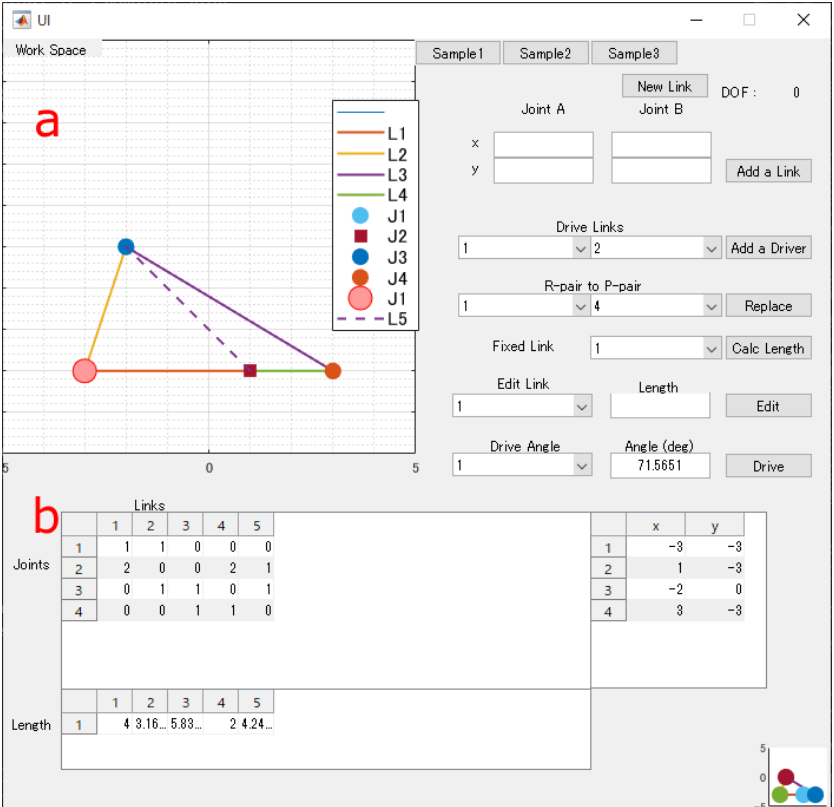
Figure 12. The schematic diagram of Slider-crank mechanism ( a ) and generated LJ-matrix ( b ).